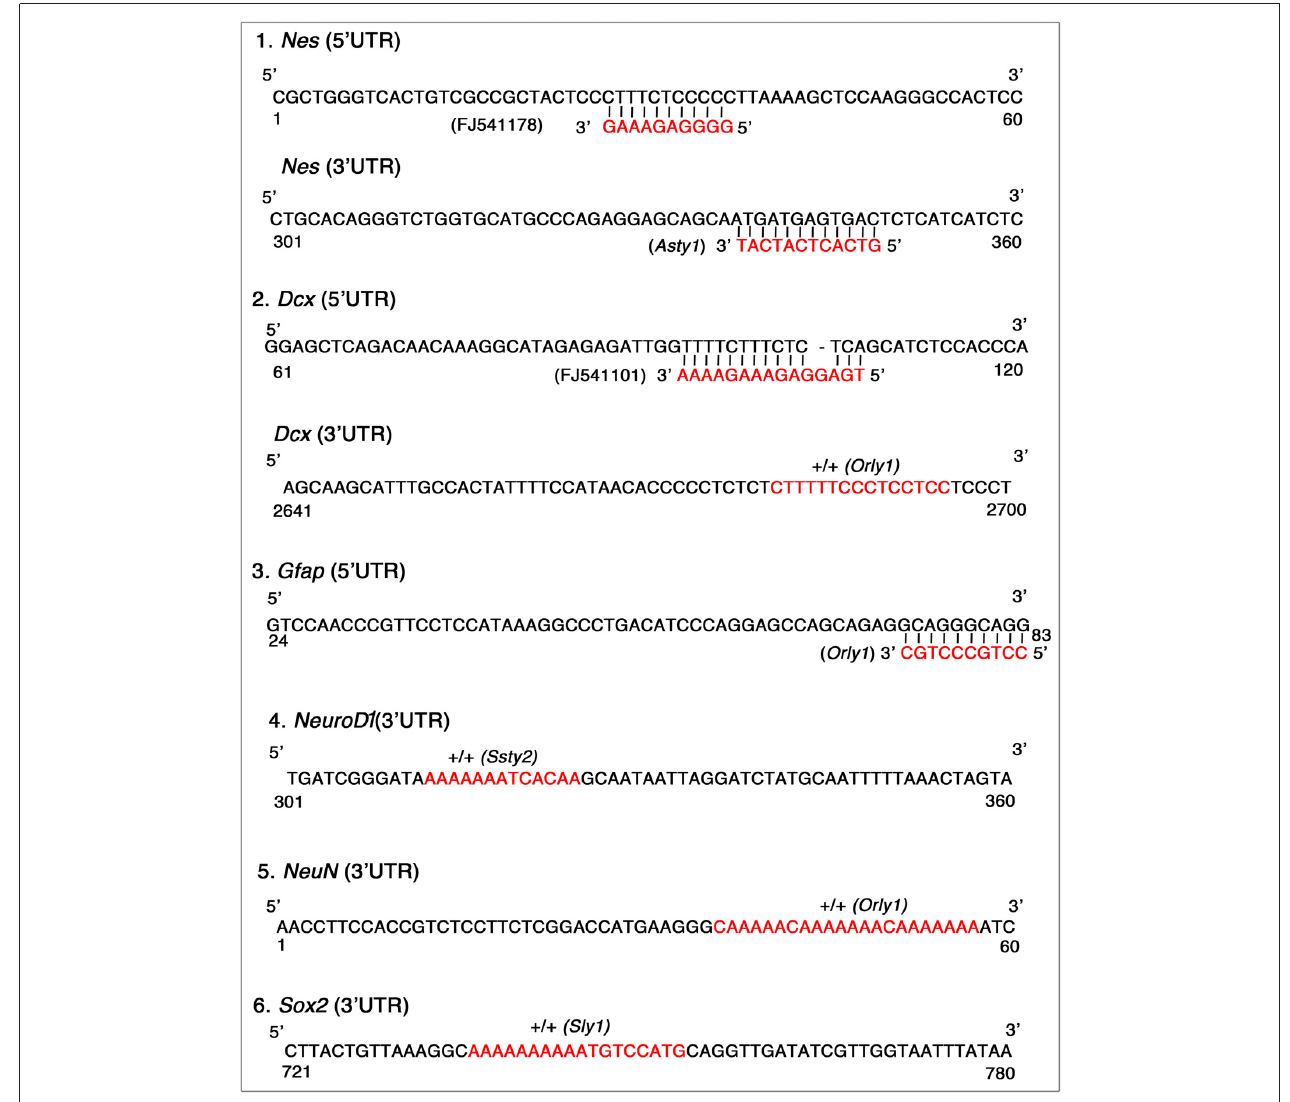
FIGURE 9 | Y-chromosomal homology in untranslated regions (UTRs) of deregulated genes in hippocampus. The short stretches of homology observed between the Y-chromosomal transcripts (red color) and the UTRs of the deregulated genes are represented in the figure. Nestin and Dcx had hits in both 5’ and 3’UTRs; Gfap had homology only in the 5’ UTR whereas Sox2 , NeuroD1 and NeuN had unique hits only in their 3’